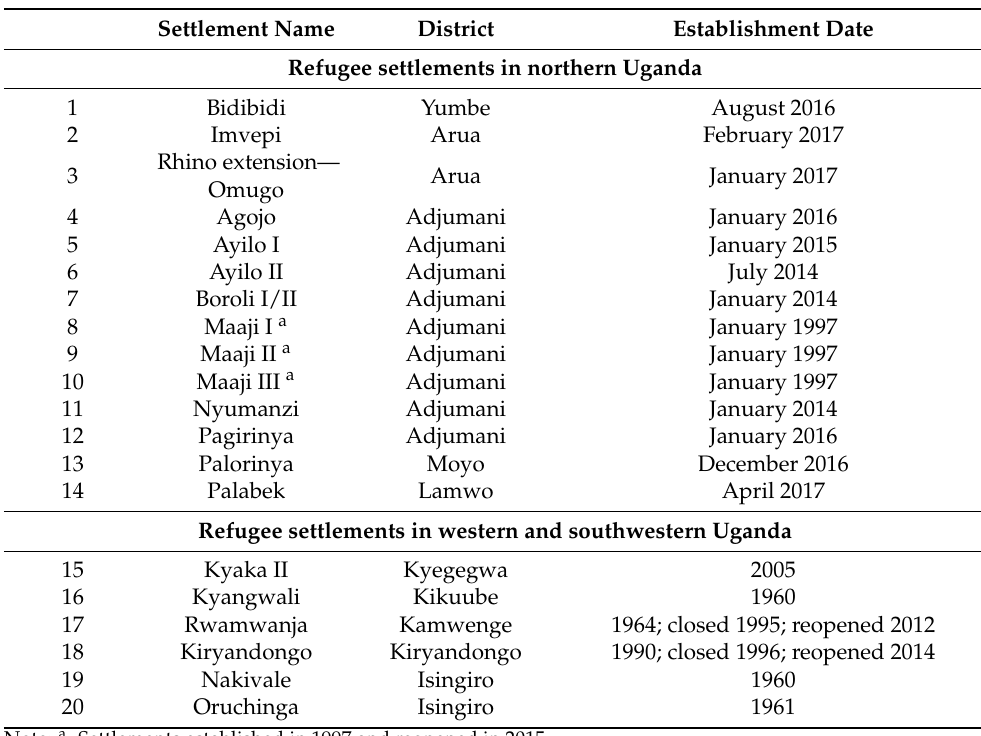
Table 1. Refugee settlements included in the assessments.